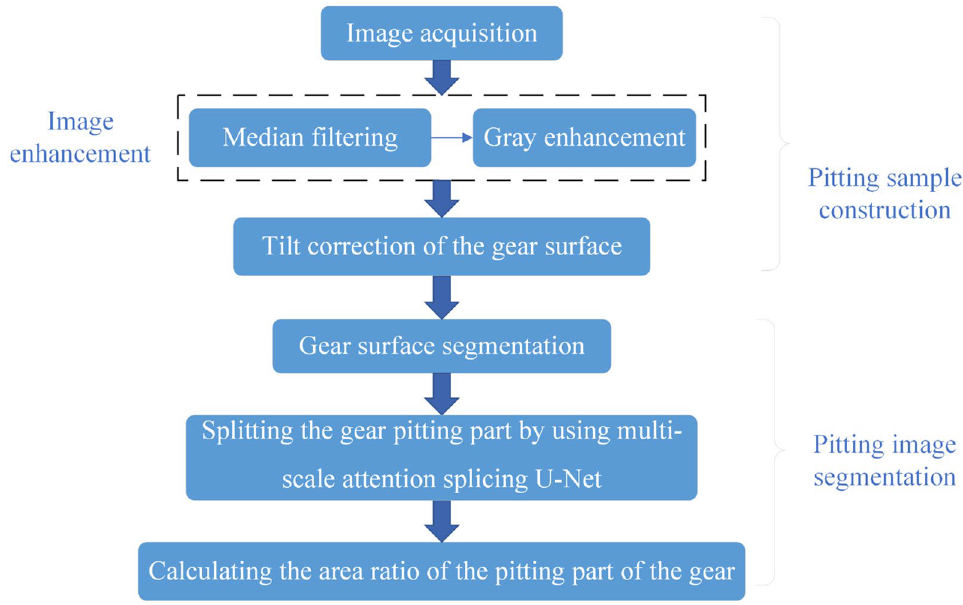
Figure 1 Flowchart of the proposed methodology for pittings